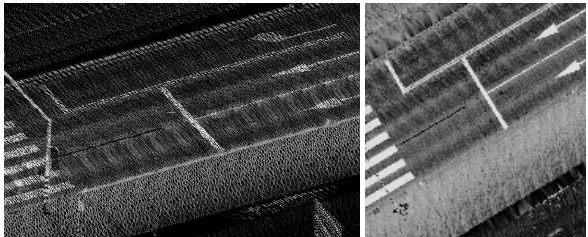
Figure 3 Point cloud patch (left) to an orthoimage